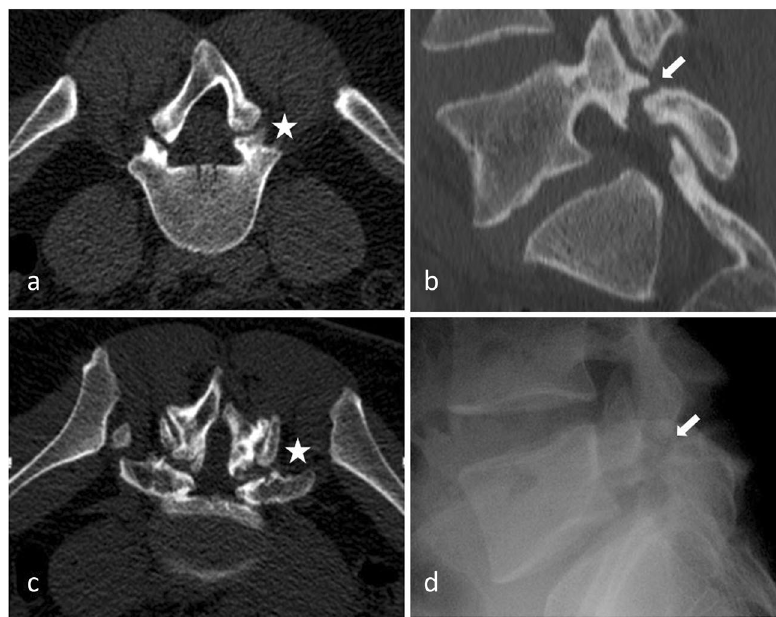
Fig. 3 Isthmic lysis. a : Axial CT view at L4 – 5 level; b : axial CT view at L5-S1 level c : X-ray sag- ittal view at L5-S1 level; d :